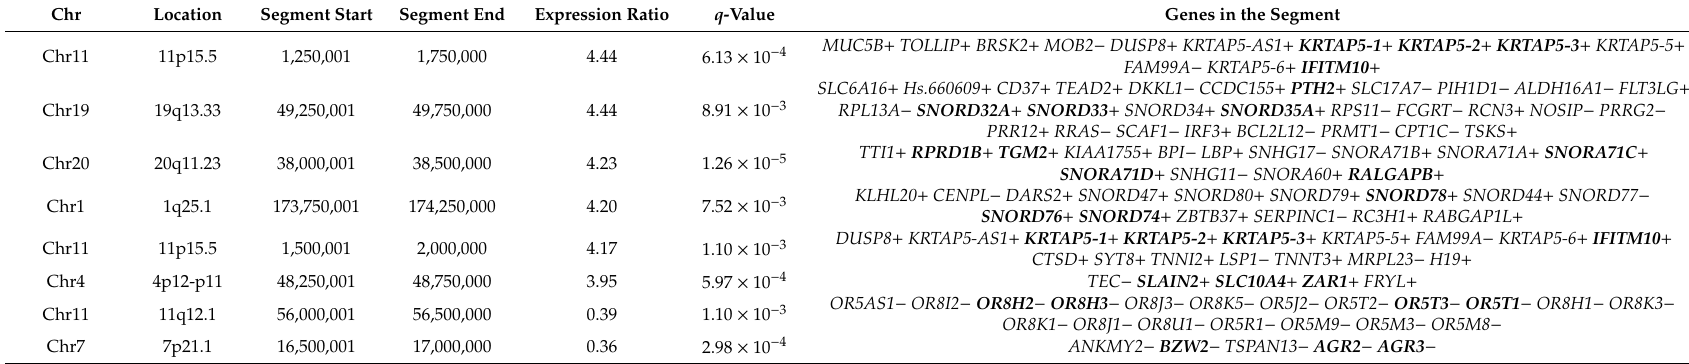
Table 4. Chromosomal segments statistically significant in TRAM “Map” mode analysis of hADSC female samples with fibroblast growth factor (FGF) vs. hADSC female samples without FGF.